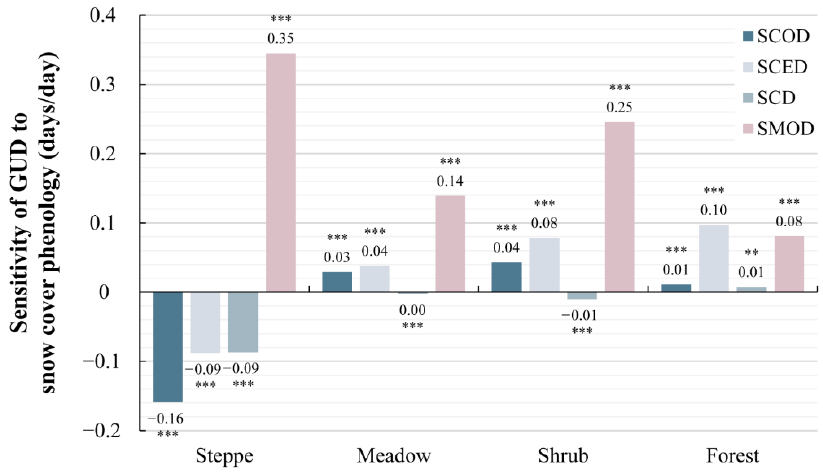
Figure 7. Sensitivity of GUD to snow cover phenology for the pixels with a significant correlation ( p < 0.01) among different vegetation types. The symbols ** and *** are significant at the levels of 0.05 and 0.01, respectively.